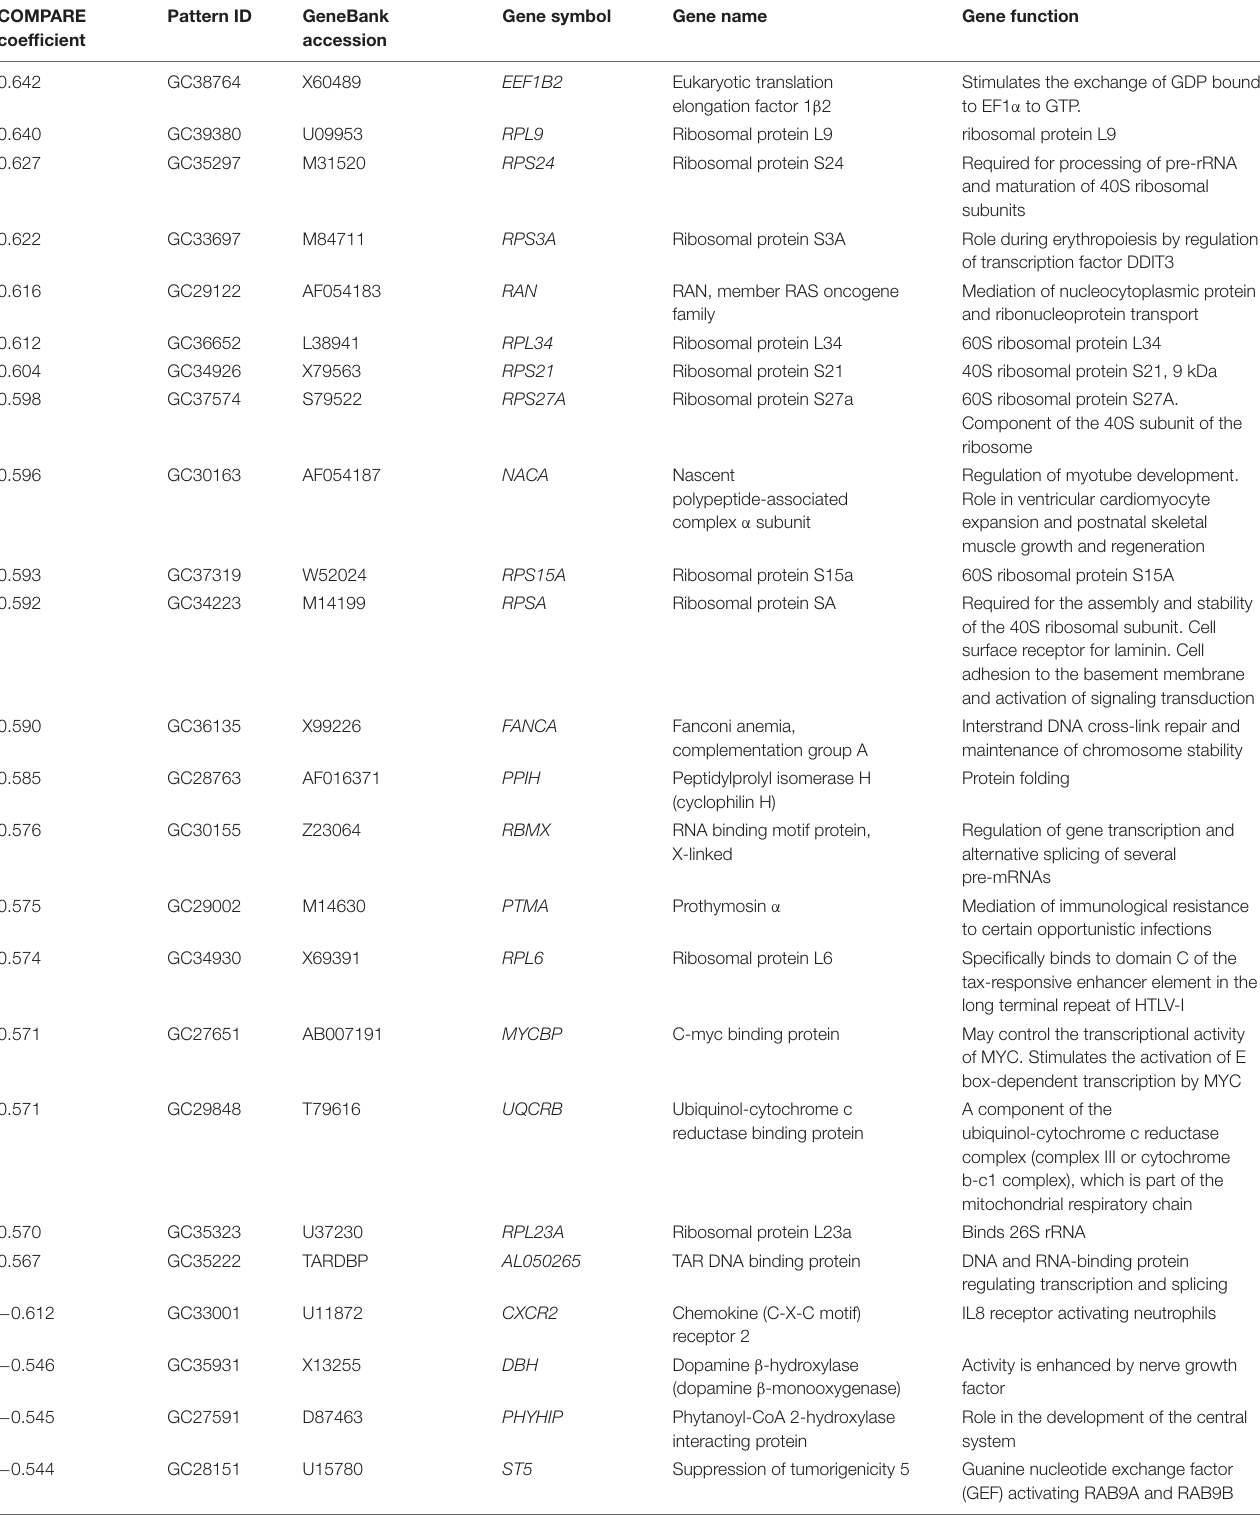
TABLE 3 | Correlation of mRNA expression of genes identified by COMPARE analysis with log 10 IC 50 values of bromocriptine for 60 NCI tumor cell lines a . COMPARE